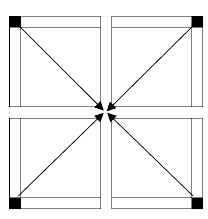
Figure 4. The four simultaneous Kalman filter processes implemented under four different boundary